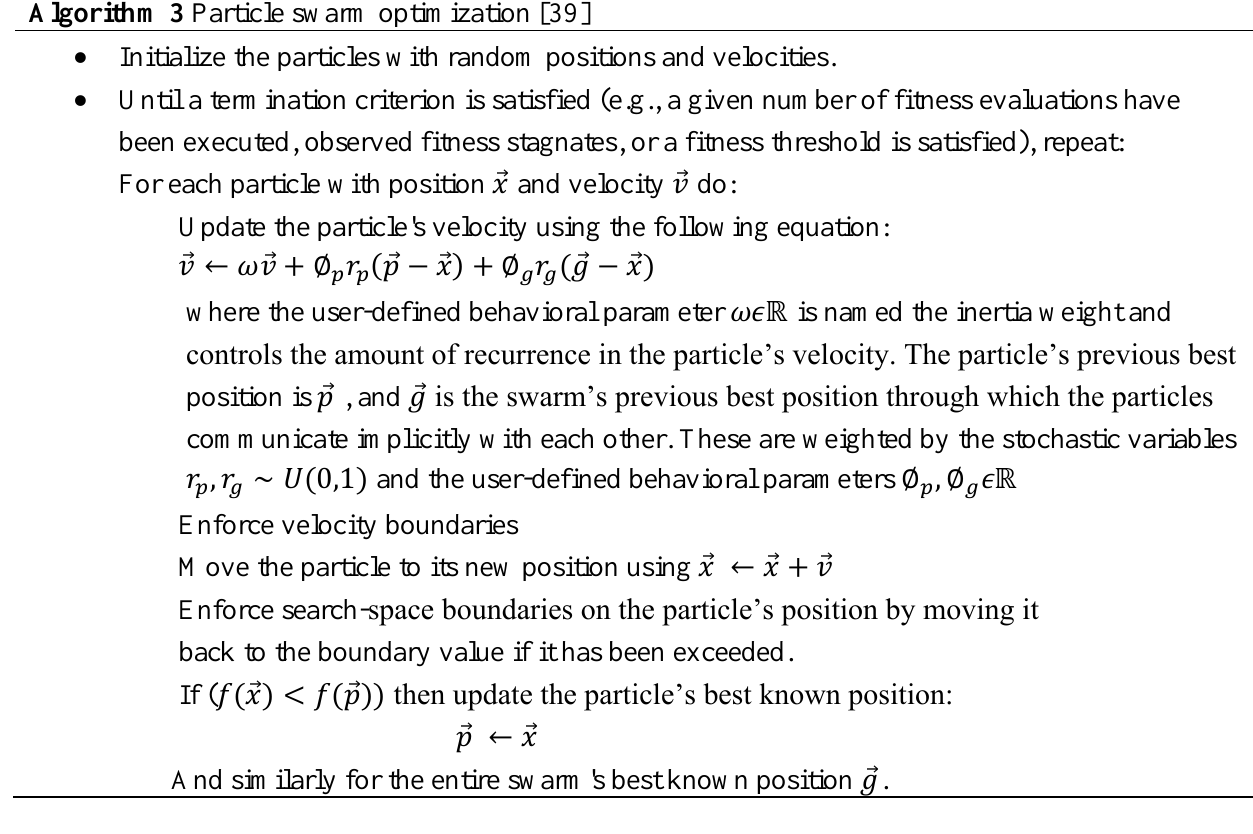
Algorithm 3 Particle swarm optimization